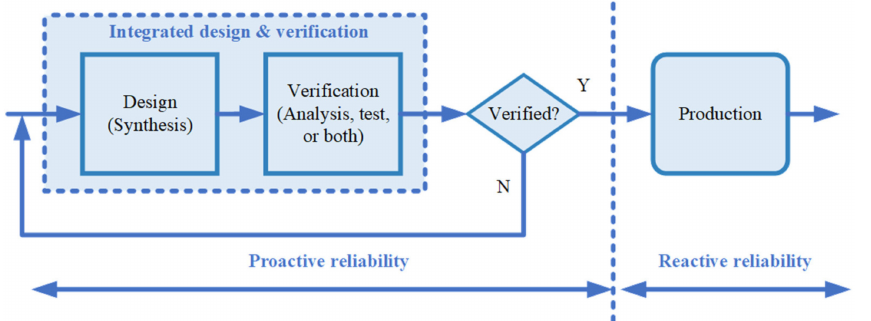
Figure 2. Proactive and reactive reliability engineering within the product lifecycle, including the Product Development (PD) process, redrawn from